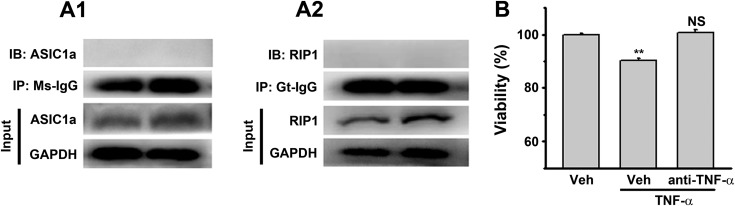
Controls for Figure 2G,H,I.(A1, A2) No ASIC1a or RIP1 was immunoprecipitated by mouse IgG (Ms-IgG) or goat IgG (Gt-IgG). (B) TNF-α neutralizing antibody (1 μg/μl) rescued TNF-α (10 ng/ml, added in culture medium)-induced neuronal death (CTB assay, n=3, **p<0.01, vs vehicle (Veh) without anti-TNF-α).